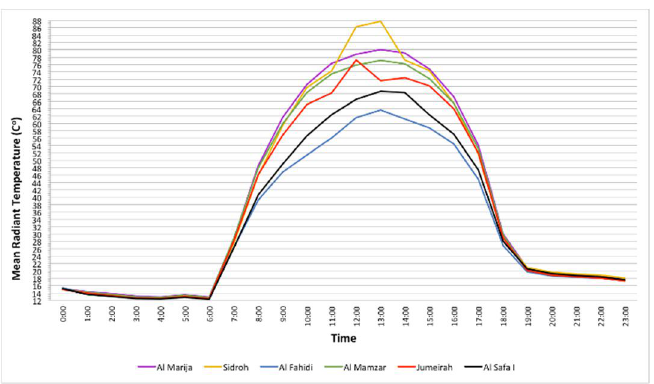
Figure 22. Average mean radiant temperature (°C) for Al Marija, Sidroh, Al Fahidi, Al Mamzar, Jumeirah, and Alsafa I in December.